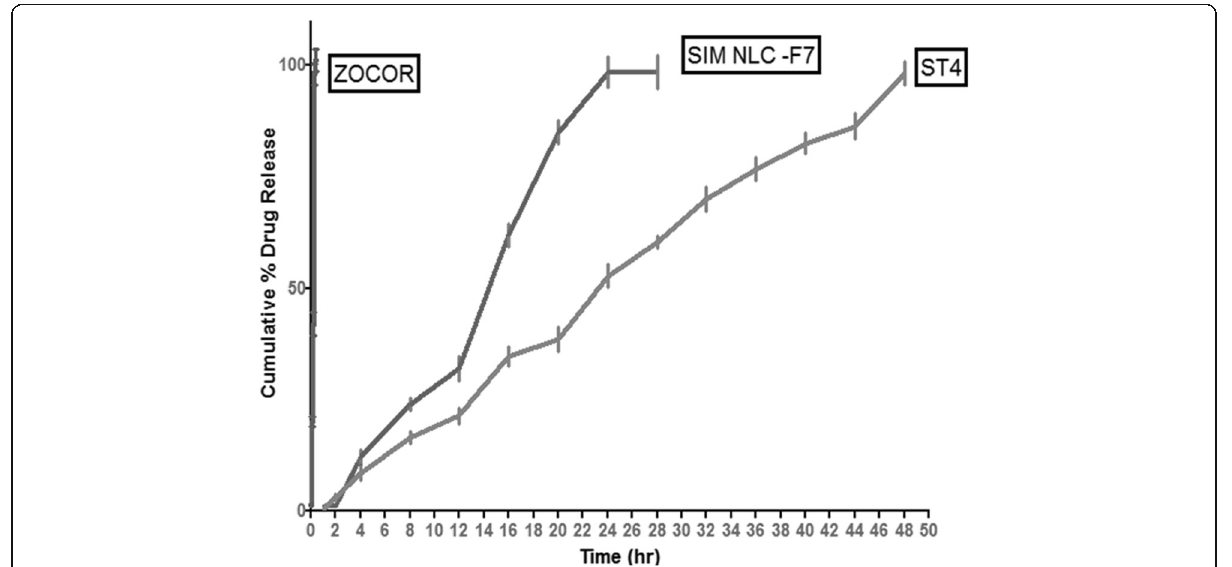
Fig. 6 Comparative drug release studies between marketed simvastatin tablet (ZOCOR), simvastatin nanostructured lipid carrier, and simvastatin nanostructured lipid carrier loaded transdermal patch (mean ± SD, n =